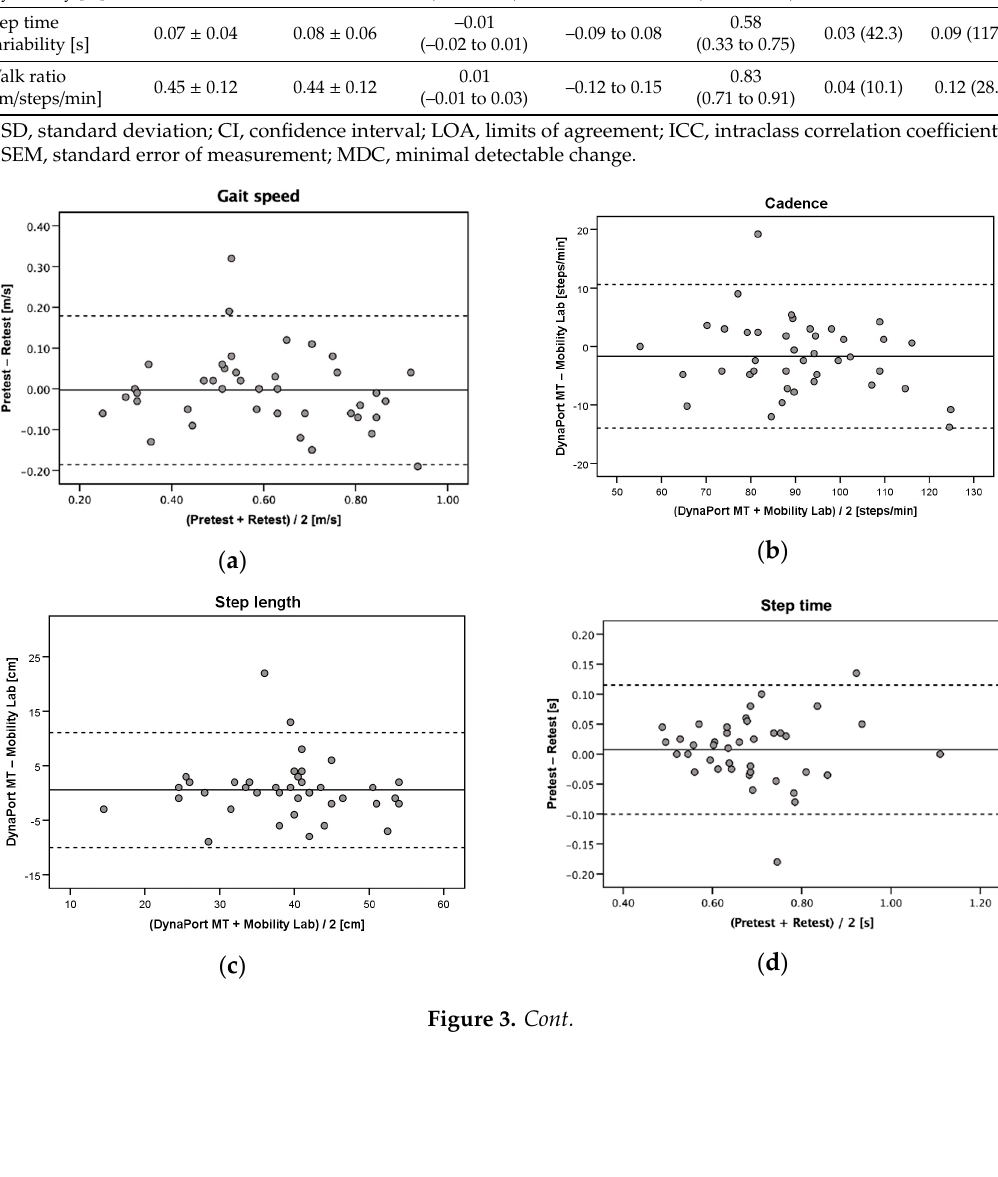
Table 3. Intra-session test-retest reliability of the DynaPort MT ( n =